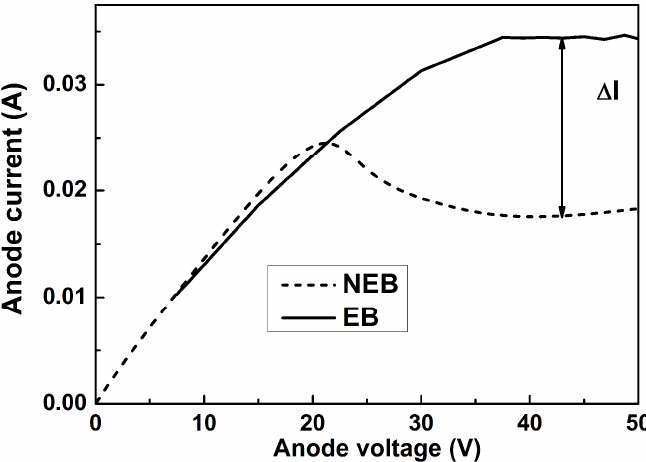
Figure 2. Simulated direct I–V characteristics of GaN Gunn diode under NEB (non-isothermal-energy-balance model) model and EB (energy-balance model) model.